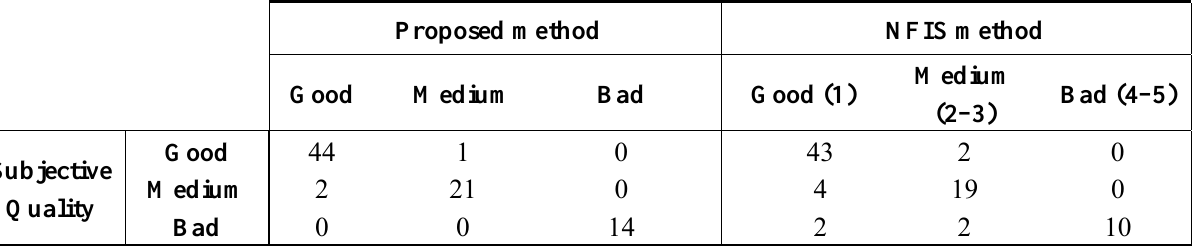
Table 6. Classification results of residue images by the proposed method and NFIS method.